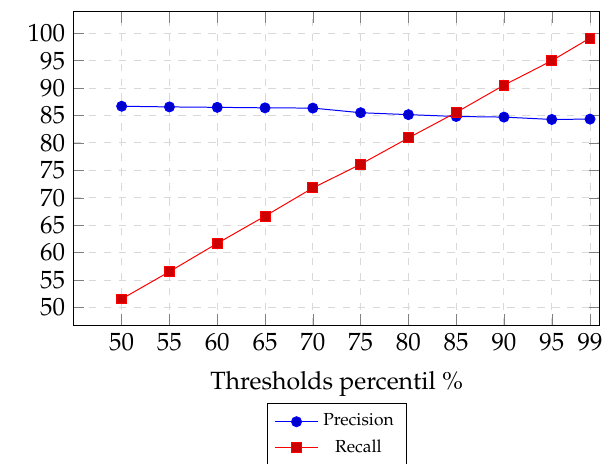
Figure 12. Second experiment—isolating class 1 from Y = “Sentiment” feature in Logistic Regression output using LOF.